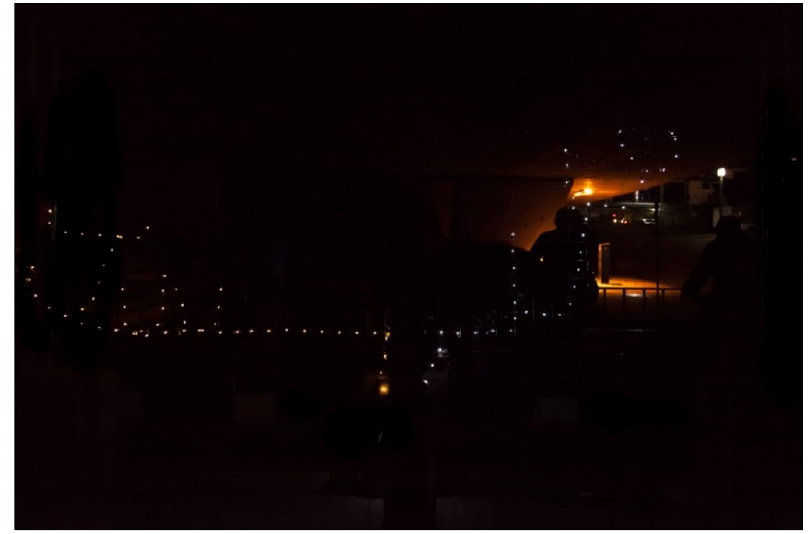
Figure 2. Participant #1 and Participant #5 in sync in ISEA Bright Future (2013).